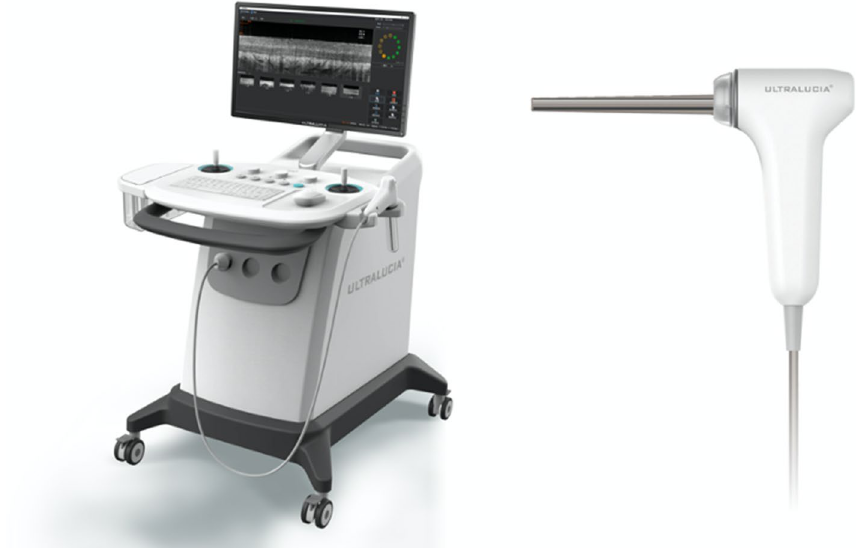
Figure 1. Ultralucia OCT cervical scanning system and handheld